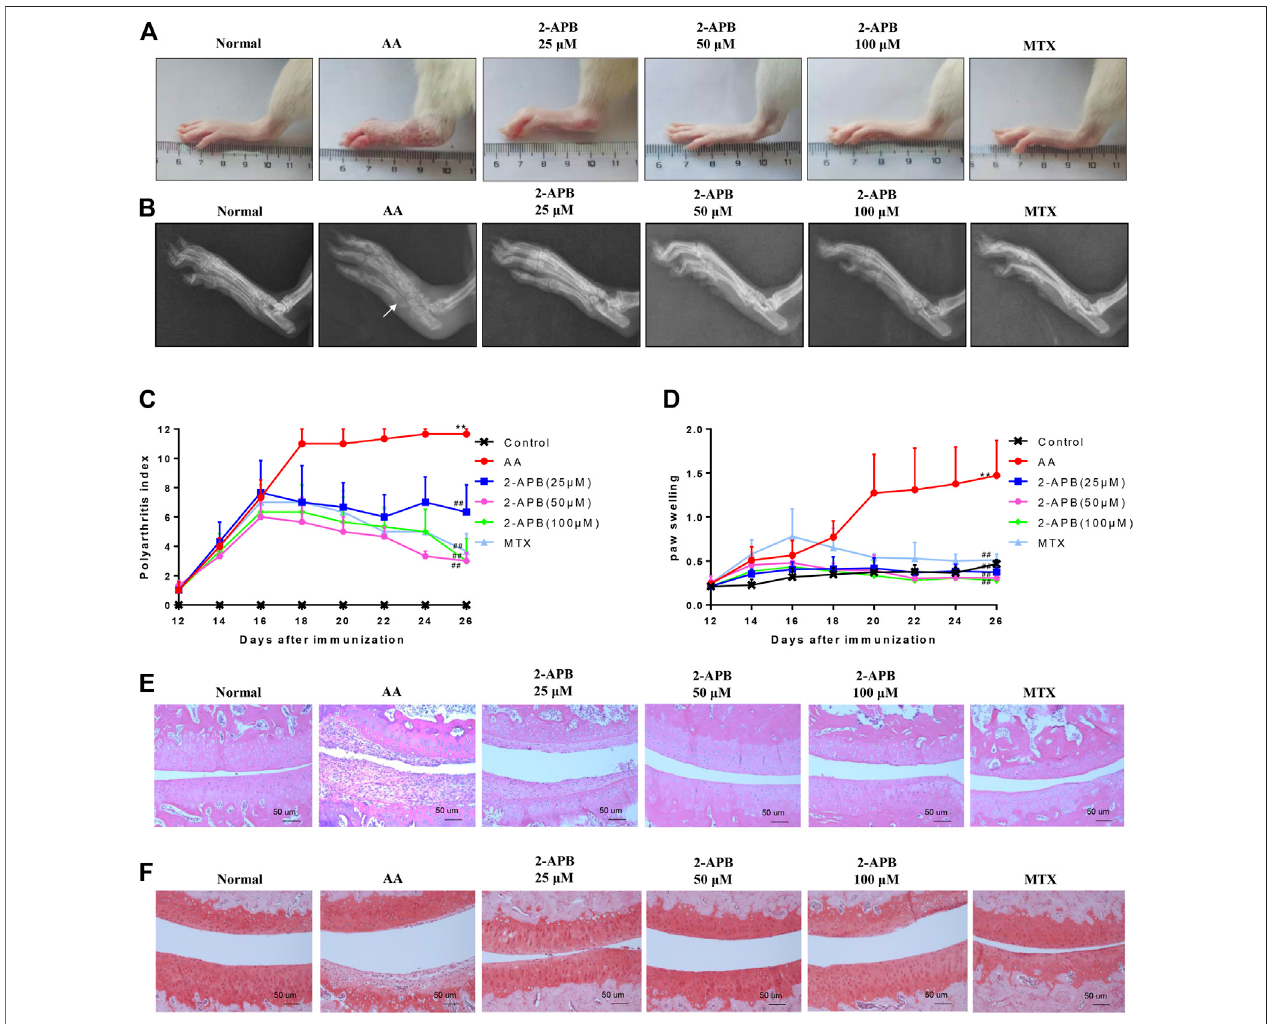
FIGURE 6 | 2-APB attenuates the clinical indications of ankle joint damage in AA rats (A) Representative images of rat paws from each group (B) Representative radiological images of rat paws from each group. White arrow: bone erosion (C,D) On days 12 – 26 after immunization, arthritis score and foot swelling of SD rats were recorded and assessed every two days (E) HE staining of ankle joint in rats from each group (F) Safranin O staining of ankle joint in rats from each group. Values are presented as mean ± SEM. n (cid:2) 8, ** p < 0.01, compared with the control group; ## p < 0.01, compared with the AA